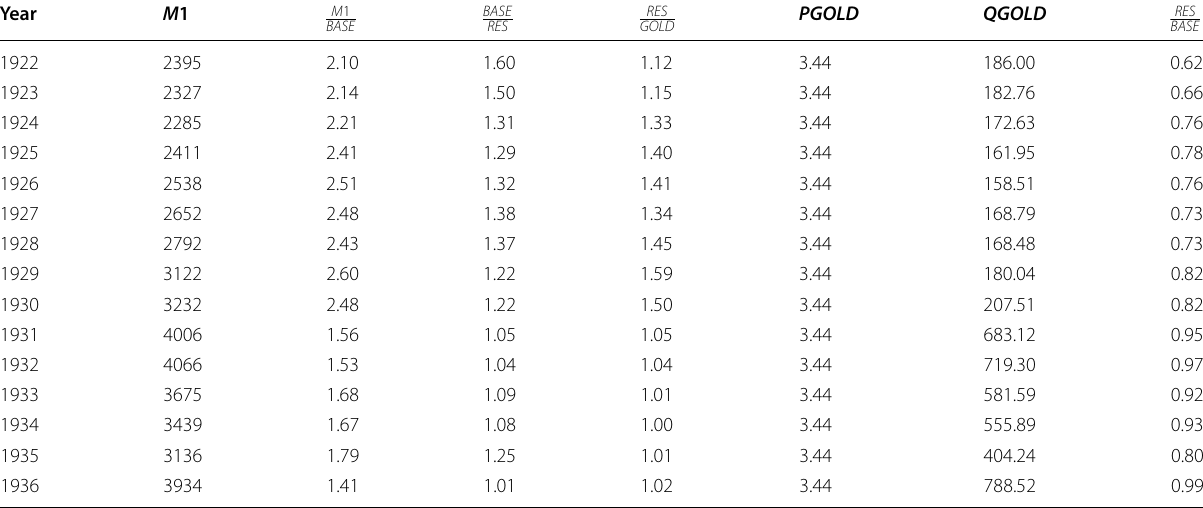
Table 1 Decomposition of Swiss Money Supply, 1922–1936 Source Swiss National Bank. www. snb. ch/n/ mmr/ refer ence/ histz_